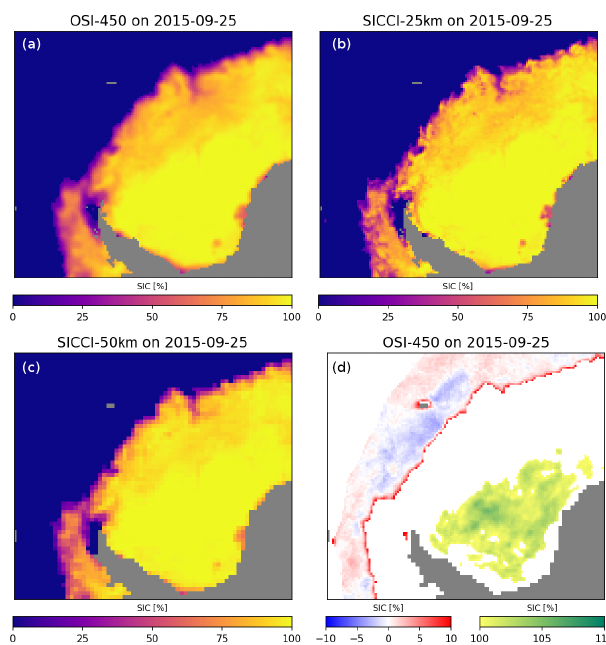
Figure 6. Example SIC fields on 25 September 2015 from the three CDRs ( a : OSI-450, b : SICCI-25km, c : SICCI-50km) over the Weddell Sea. Panel (d) shows the content of variable raw_ice_conc_values from the OSI-450 file for the same date and area. Note the two discontinuous colour scales for (d)